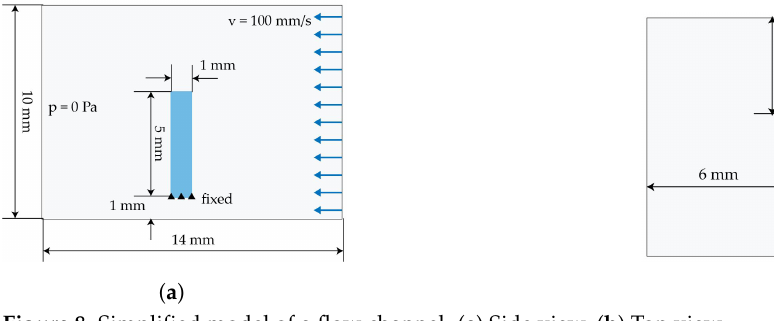
Figure 8. Simplified model of a flow channel. ( a ) Side view. ( b ) Top view. Table 6. Numerical parameters for the laminar channel flow